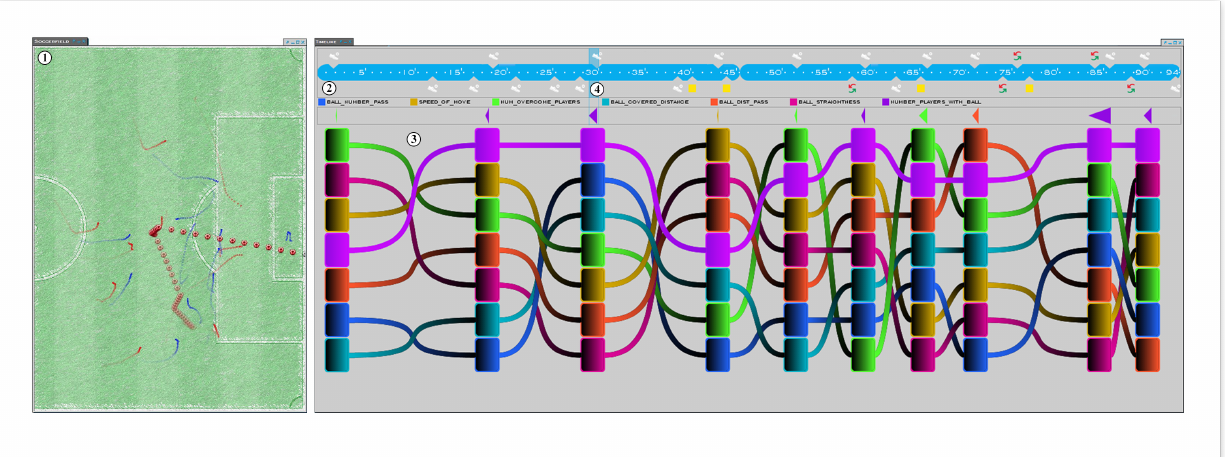
Figure 1. We display a teams’ situations of interest combined with their visualization of certain characteristics (features). On the left side is the soccer pitch ( 1 (cid:13) ), where the player and ball movement is displayed with the color of their teams. The timeline visualization ( 2 (cid:13) ) allows quick navigation and can be used to jump to any moment of a match. Semi-automatically-identified interesting moves and their characteristics are displayed in a flow-like visualization ( 3 (cid:13) ). For the currently-selected move ( 4 (cid:13) ), we immediately identify the highlighted purple-colored feature (the number of players that participated in an attack) as an outstanding semantic feature being almost always at the first or second ranked